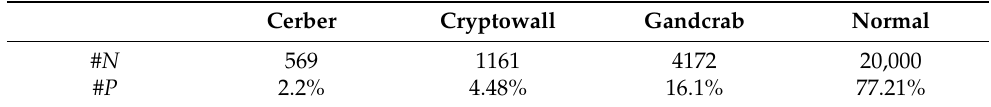
Table 4. Sample numbers of Dataset 2.